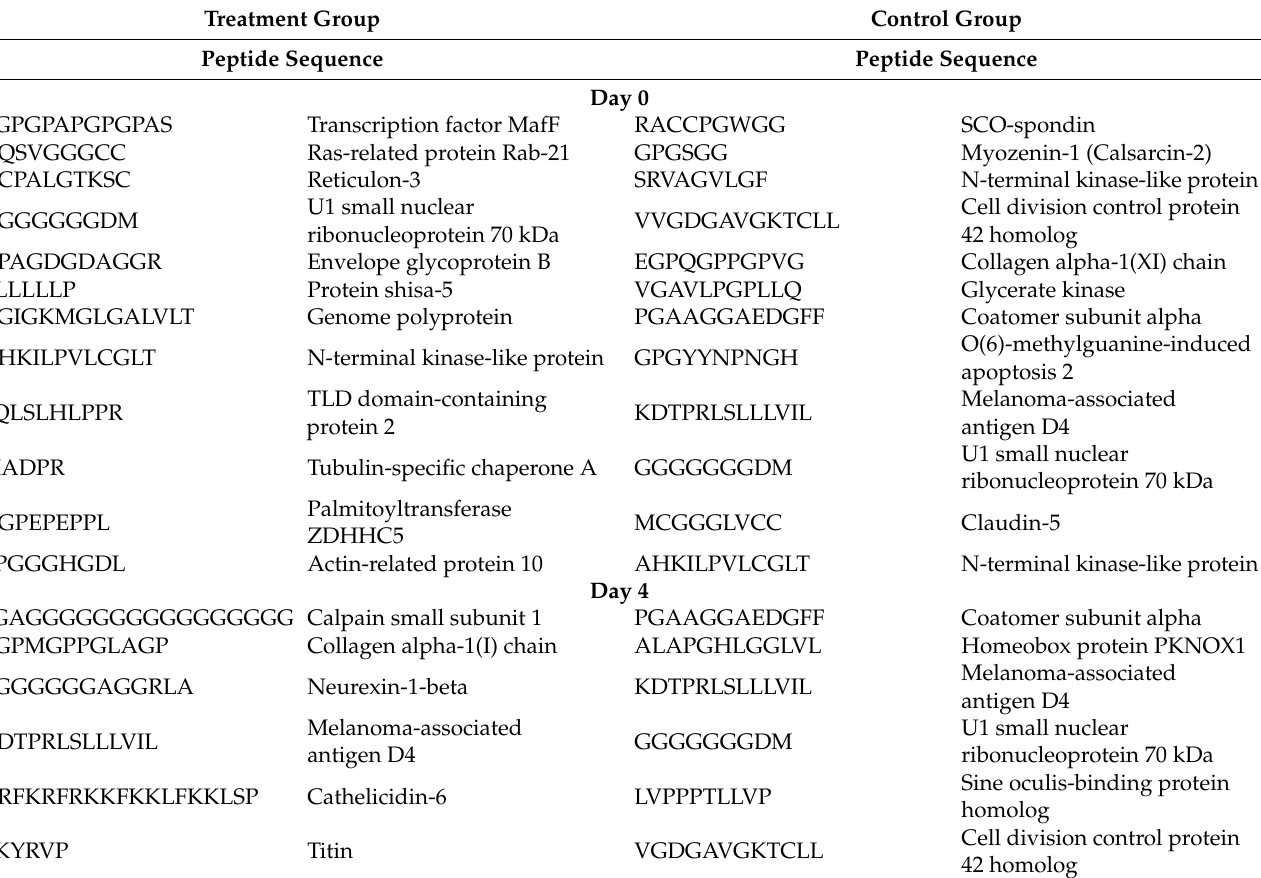
Table 1. Types of polypeptides of sausage during processing by